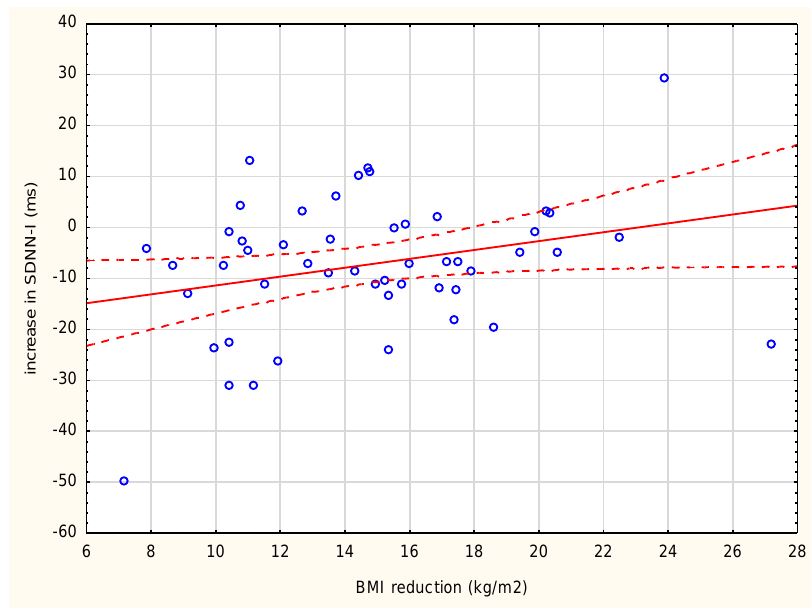
Figure 2. Correlation between the reduction in body mass index and the increase in SDNN-I value (r = 0.281, p = 0.04) in all 50 patients after follow-up period. In addition, no significant differences in parameters of carbohydrate metabolism, HRV and HRT were observed after follow-up in patients divided according to the degree of weight reduction expressed by median of final BMI or final WC—results in Table 3. There were also no significant differences in the improvement of patients’ HRV parame- ters according to the median follow-up period (<15 vs. ≥ 15 months)—detailed data are not shown. Table 3. Comparison of indices of carbohydrate metabolism, time-domain heart rate variability and heart rate turbulence in groups divided according to the median reduction of body mass index and the median reduction of waist circumference.